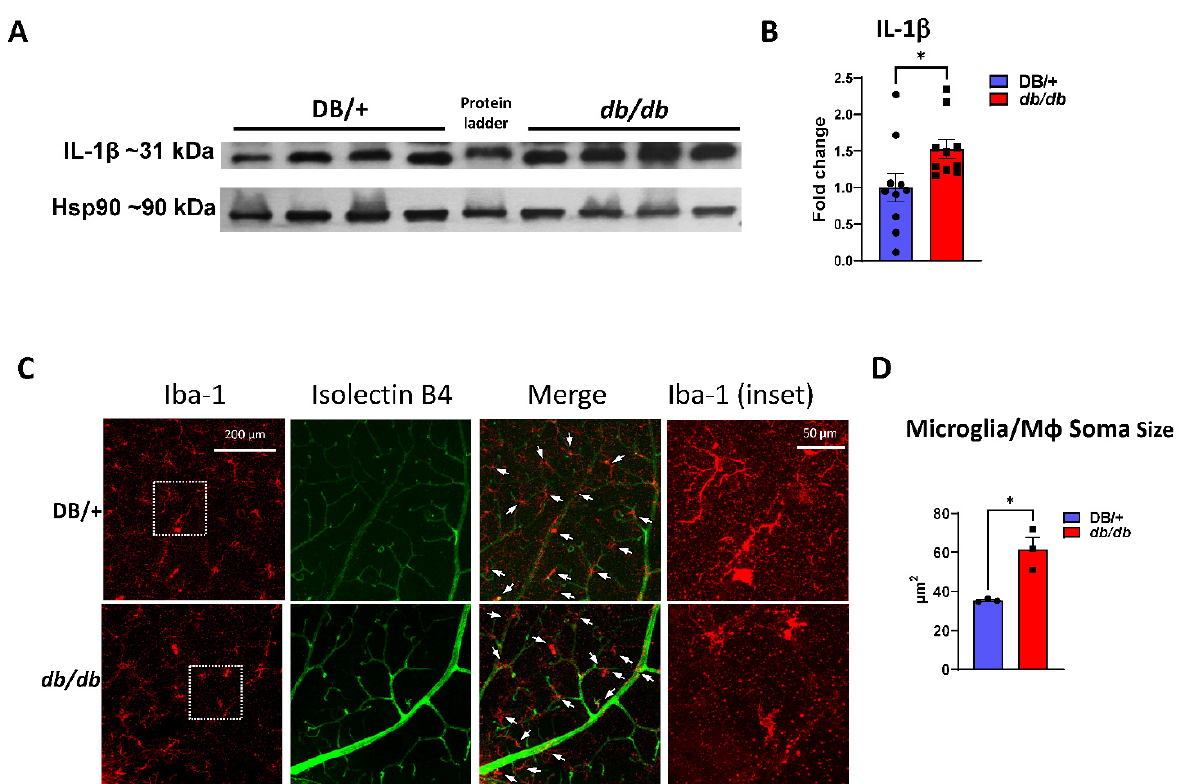
Figure 5. Elevated retinal inflammation and M Φ /microglia soma enlargement in db/db mice. ( A ) Representative Western blots of IL-1 β in retinal protein lysates with quantification in ( B ), demon- strating significant increases in IL-1 β (n = 10) expression in db/db mice compared with the lean DB/+ controls. ( C ) Retinal flat-mounts imaged at the level of the superficial vascular plexus and labeled with isolectin B4 (vasculature) and Iba-1 (M Φ /microglia). White arrows point to the perivascular macrophages with Iba-1 in the enlarged inset (boxed in white) showing exceptionally enlarged peri- vascular M Φ /microglia. ( D ) Quantification of M Φ /microglia soma size, demonstrating a significant size increase in db/db mouse retinas compared with the lean controls (n = 3 mice/genotype, * p < 0.05). Data are presented as the mean ± SEM.